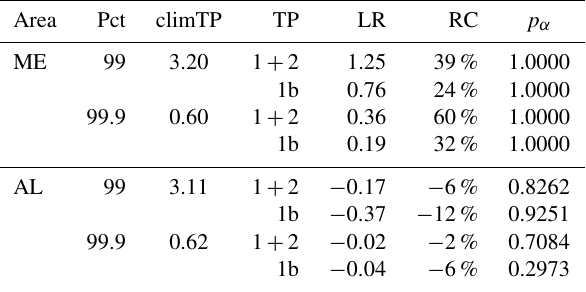
Table 4. Climatological mean (climTP; 1961–1990) of days per year exceeding the 99th and 99.9th percentiles (Pct; wet days only) for ME and AL, linear regression (LR) and relative change (RC) compared to climTP for different TPs, and related significance ( p value; α = 0 . 05).